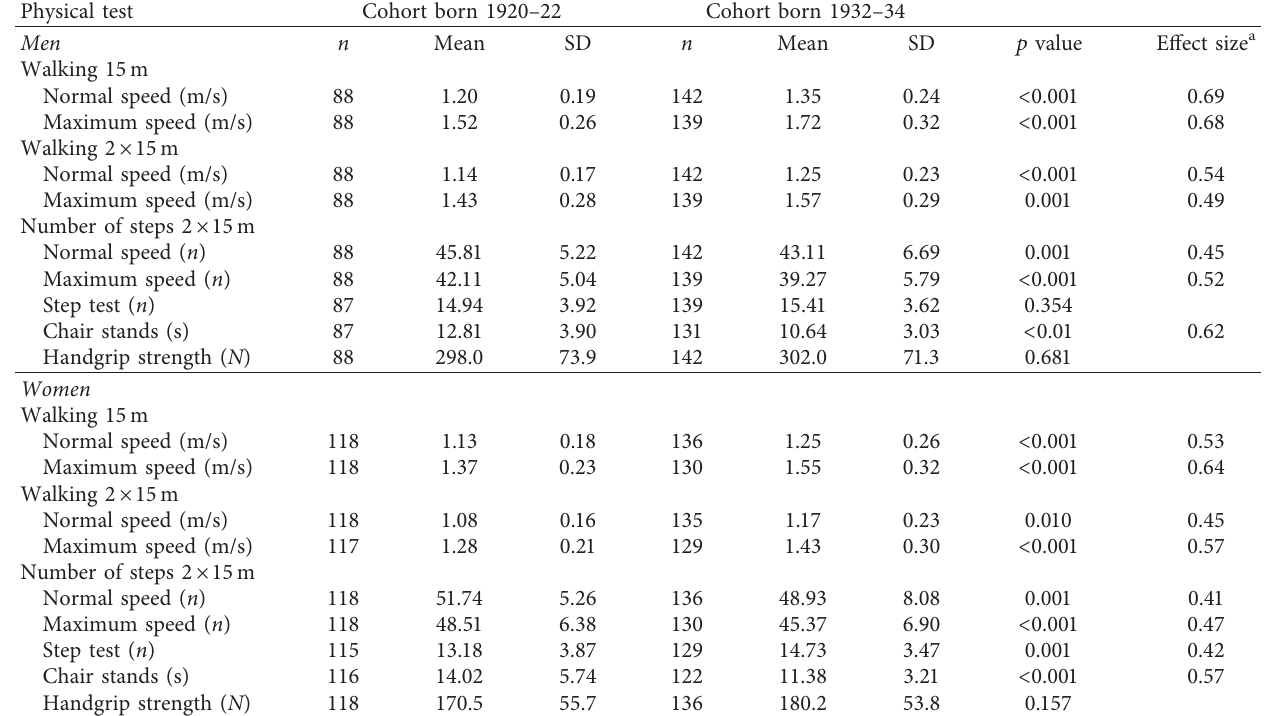
Table 3: Results of walking speed test, number of steps, step test, chair stand test, and handgrip strength test. Comparison between two